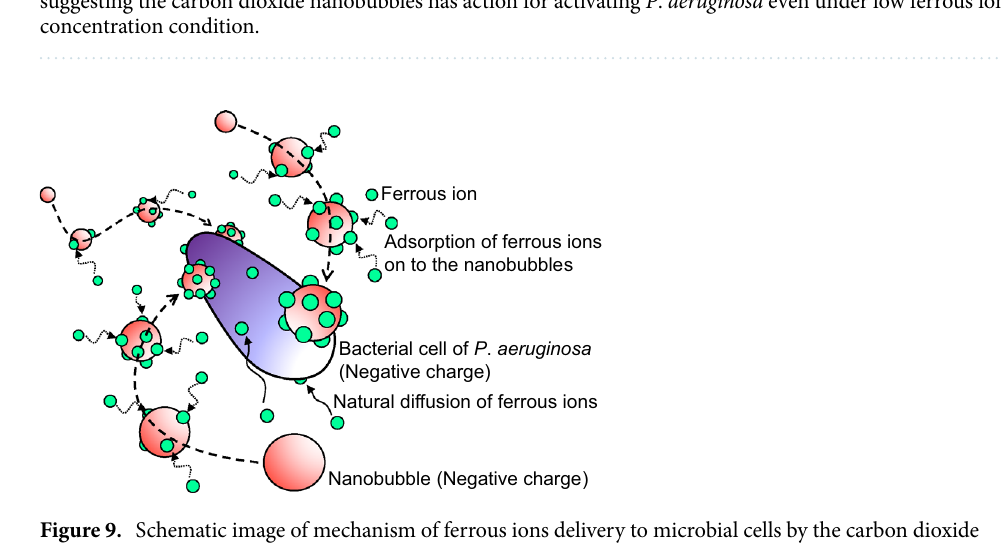
Figure 9. Schematic image of mechanism of ferrous ions delivery to microbial cells by the carbon dioxide nanobubbles. Because the carbon dioxide nanobubbles (red spheres) are negatively charged, cations including ferrous ions (green spheres) are adsorbed on to the surface of the carbon dioxide nanobubbles and change to positive charges. Because bacterial cells (purple rod) are also negatively charged, the carbon